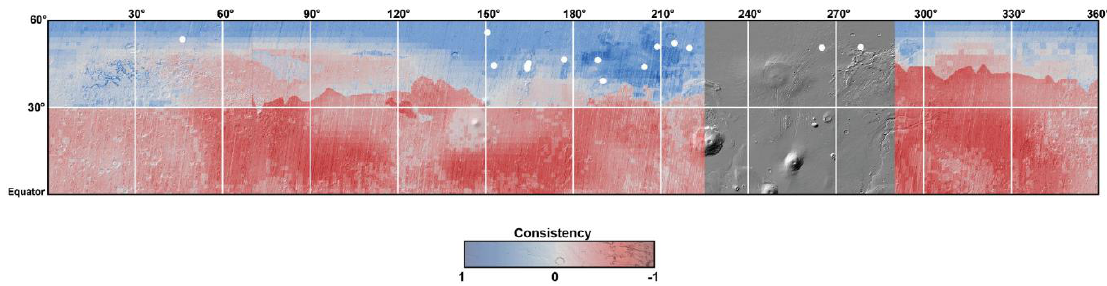
Figure 9. Subsurface water ice consistency map for the northern hemisphere of Mars.